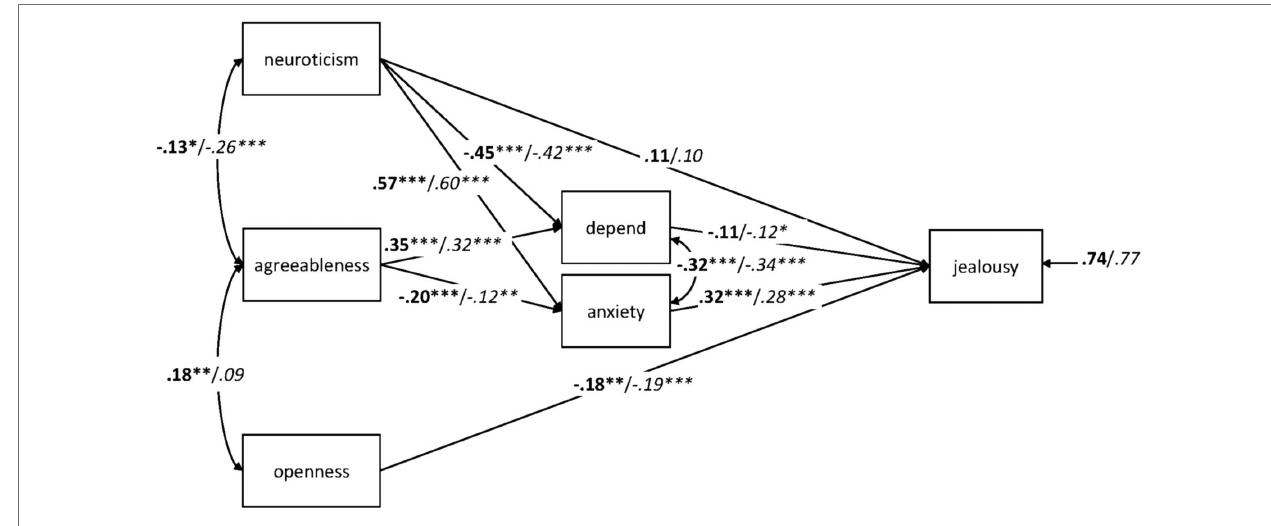
FIGURE 4 | Path analysis with standardized estimates for the relationships between the adult attachment subscales depend and anxiety , neuroticism, agreeableness, openness, and jealousy in 232 individuals with previous infidelity experiences (bold) and 398 individuals without such experiences (italics). * p < 0.05; ** p < 0.01; *** p <